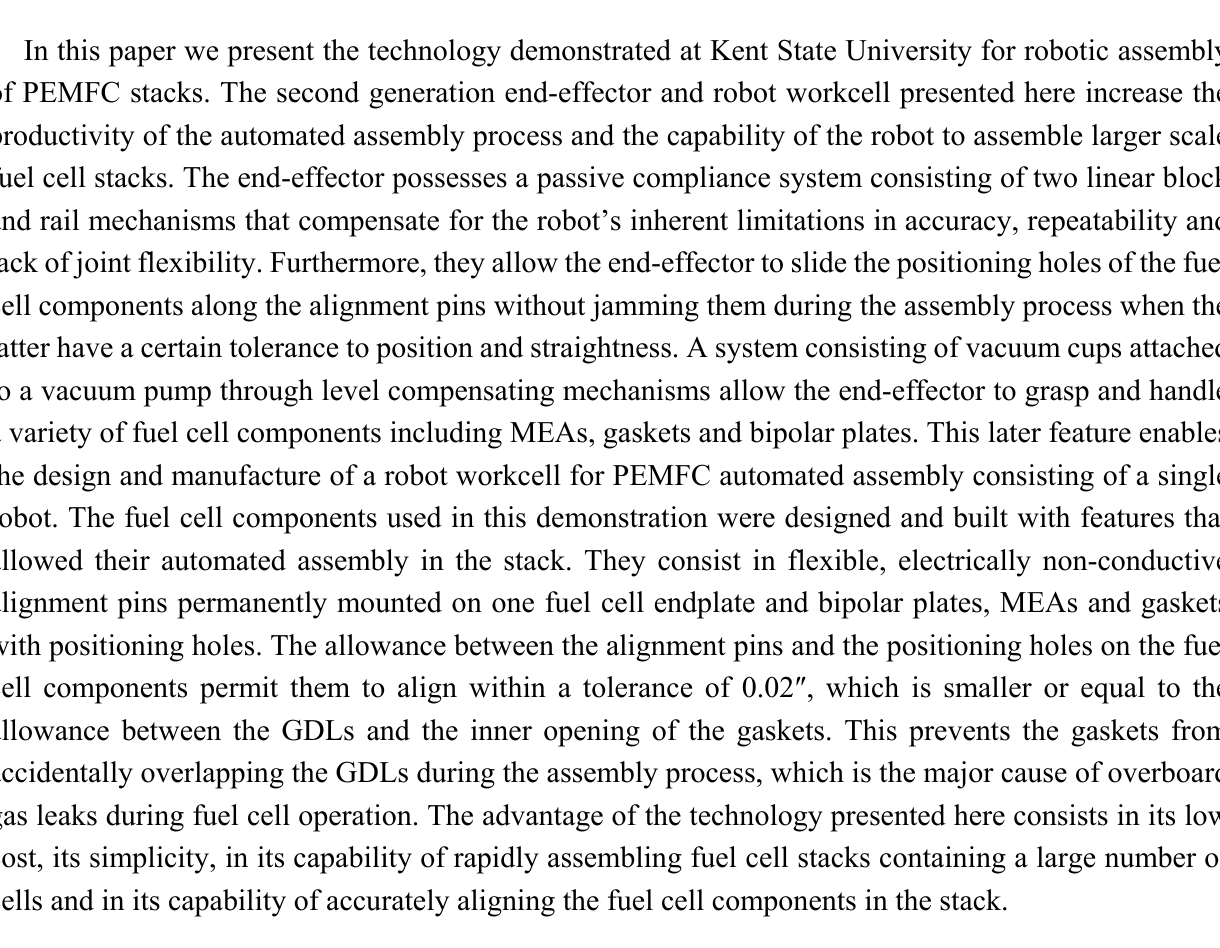
Reference [8] 80 s (see Note) No